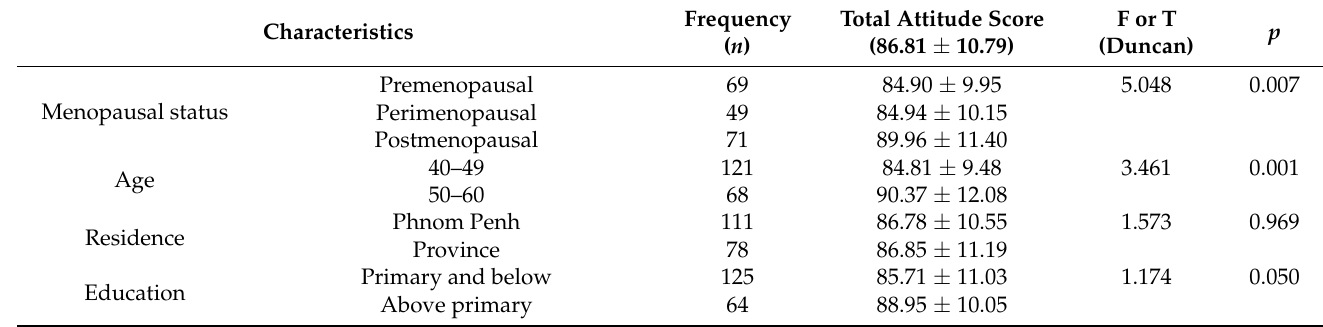
Table 3. Total attitude scores by participant